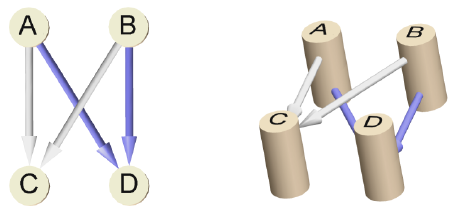
Fig. 4. Crossings between edges in different strata can be resolved by 3D rotation: left - top view, right - rotated